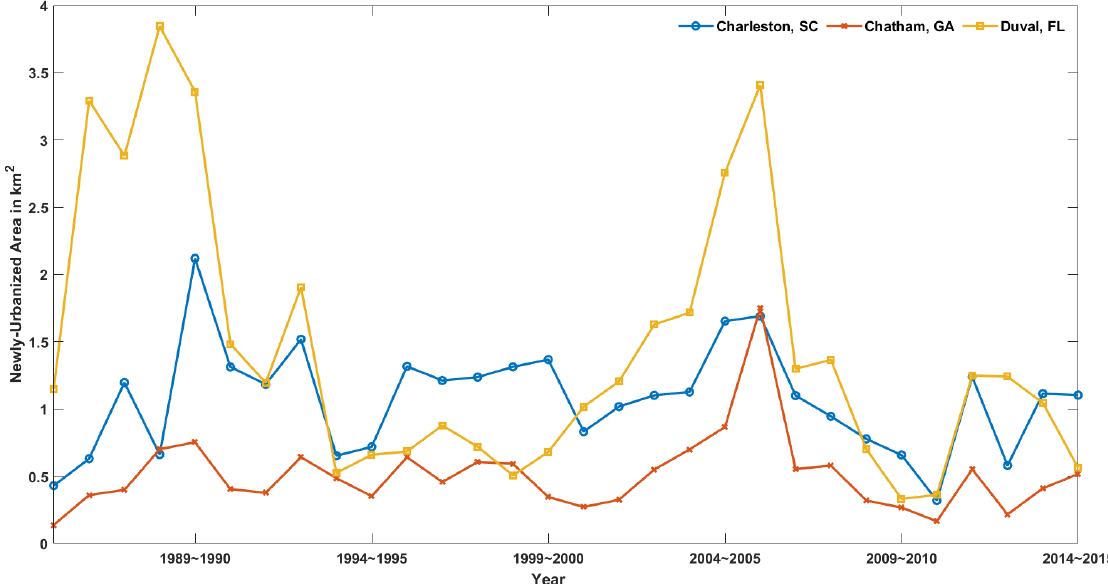
Figure 9. The annual distribution of newly urbanized lands which locate within 2 km of the coast in the three counties.